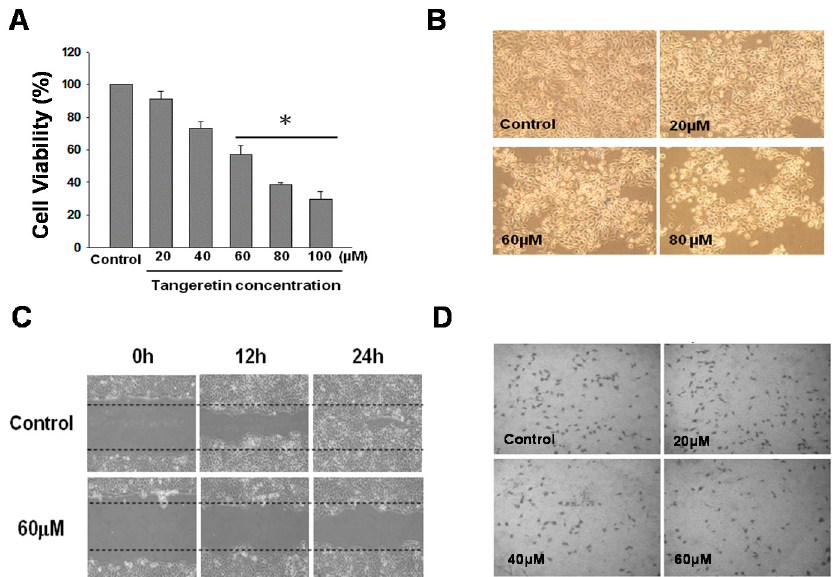
Figure 2. Effect of tangeretin on the cellular behavior of BFTC-905 cells. (100 × magnification) ( A ) Effect of tangeretin on cell viability. # p < 0.05, * p < 0.001. ( B ) Change in cell morphology after tangeretin treatment. ( C ) Effect of tangeretin on wound-healing. ( D ) Effect of tangeretin in a transwell migration assay.